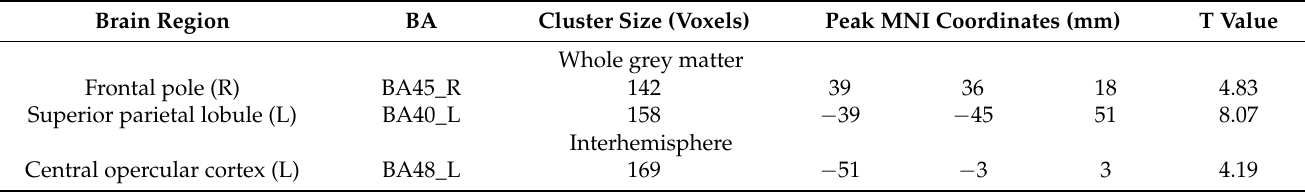
Table 4. Significant differences in regional DC between TP1 and